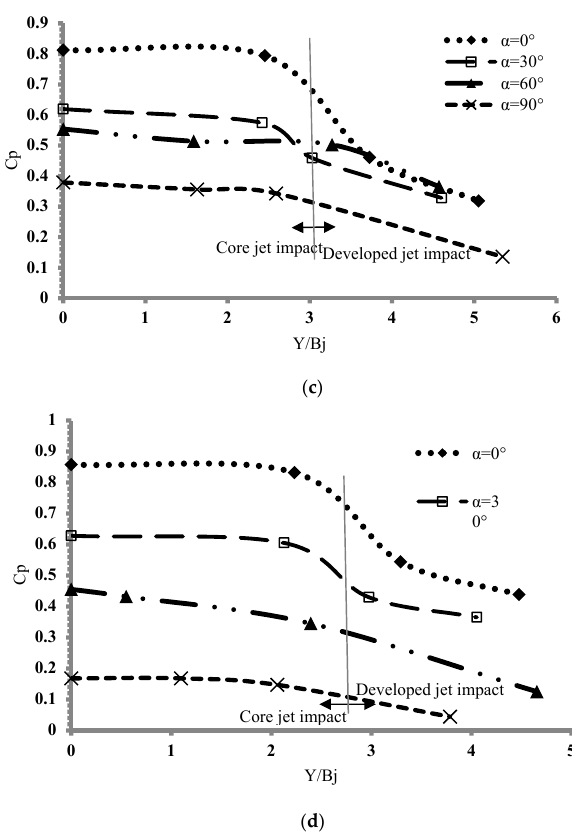
Figure 4. Variations of mean dynamic pressure coefficient versus the plunging depth ratio in discharges of ( a ) 67; ( b ) 86; ( c ) 161; and ( d ) 184 L/s.